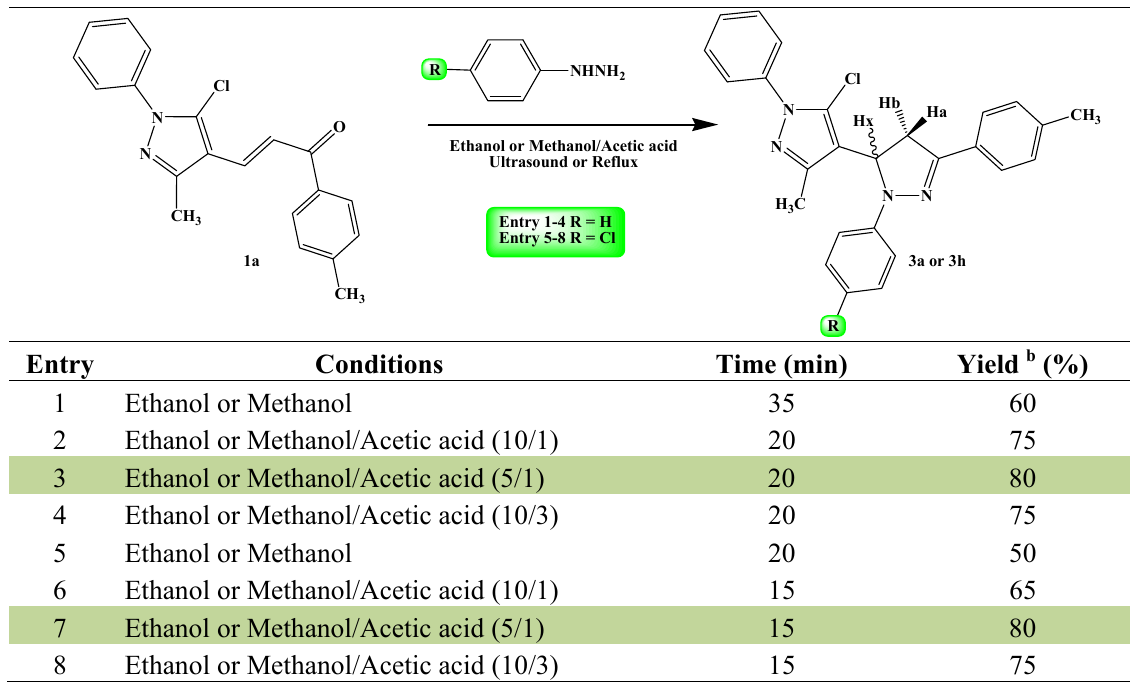
Table 1. Effect of reaction conditions. Green factors.